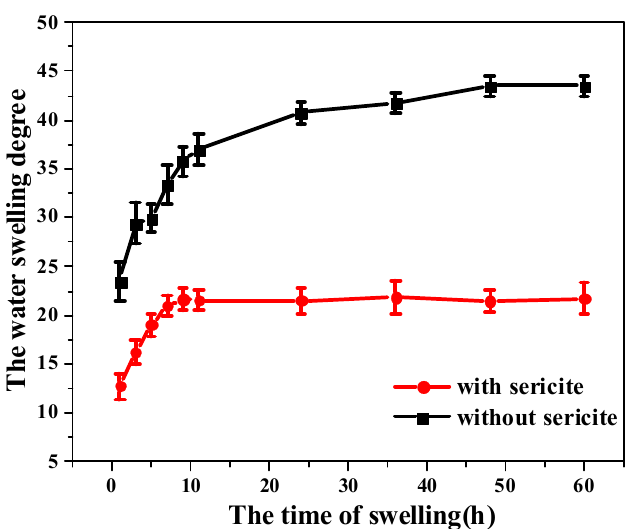
Figure 4. The water swelling degree of the plugging agent at room temperature.